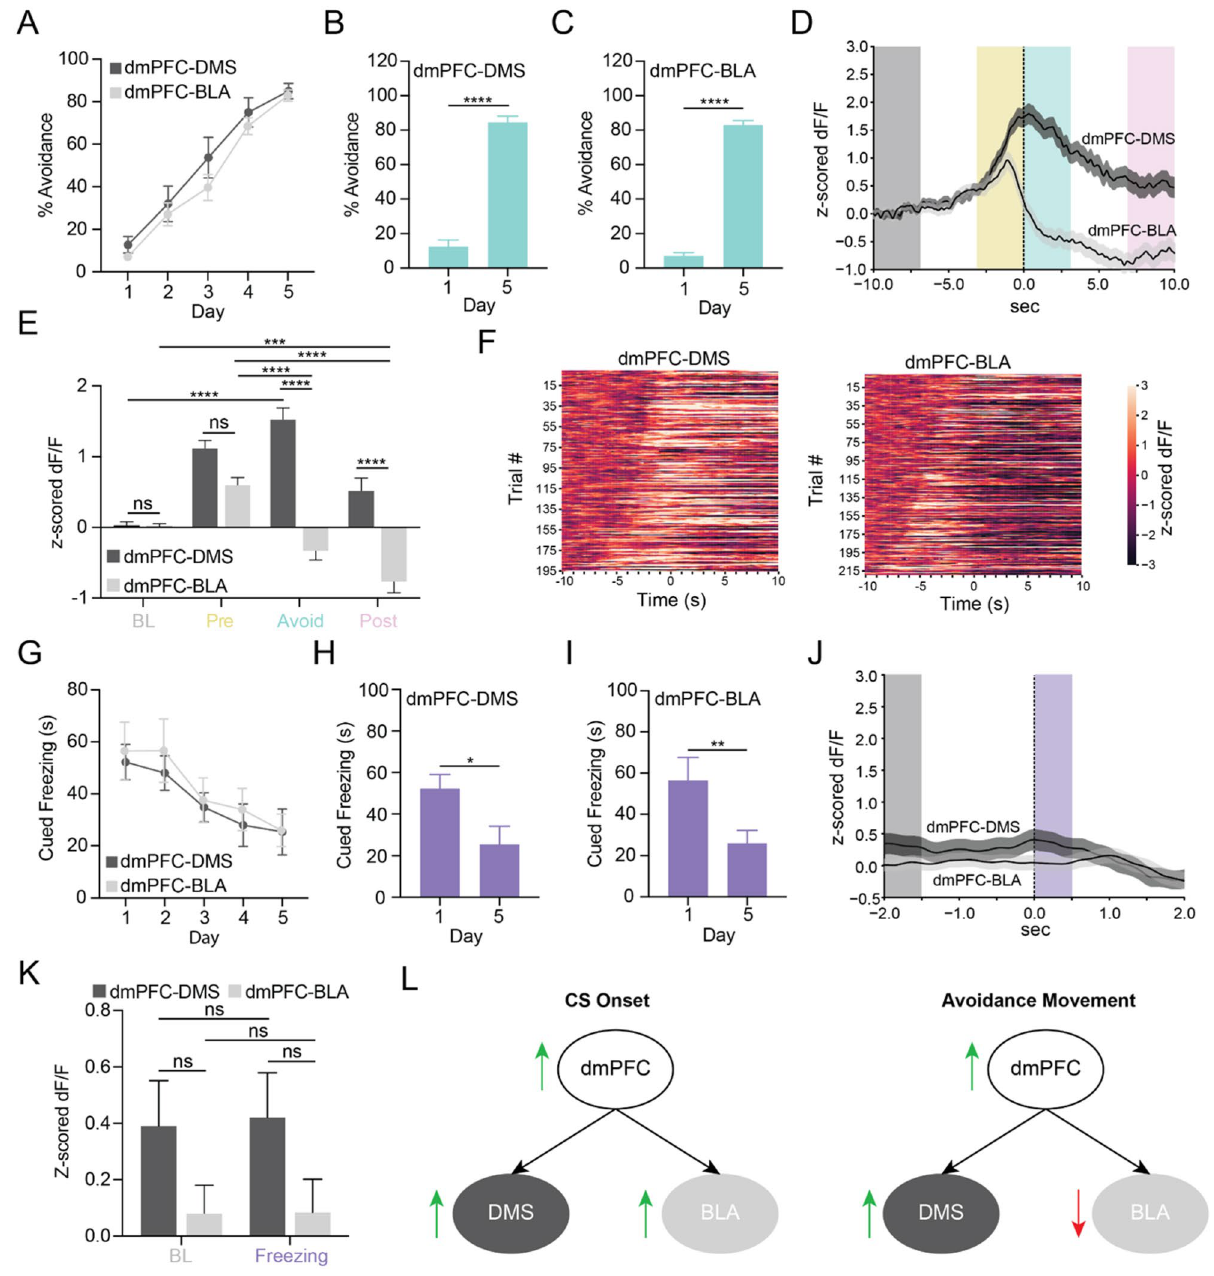
Figure 4. dmPFC-DMS and dmPFC-BLA projections show divergent encoding of active avoidance behavior. ( A ) Percent avoidance across training days in the dmPFC-DMS (dark grey line) and dmPFC-BLA (light grey line) cohort. ( B , C ) Percent avoidance significantly increases from Day 1 to Day 5 in the dmPFC-DMS (left) and dmPFC-BLA (right) cohort. ( D ) PETH shows increase in calcium signal in the dmPFC-DMS projection and decrease in calcium signal in the dmPFC-BLA projection during avoidance onset on Day 5. Dark grey line, mean ± SEM for dmPFC-DMS projection; light grey line, mean ± SEM for dmPFC-BLA projection; Grey box, baseline period (BL); yellow box, pre-avoidance period (Pre); teal box, avoidance period (Avoid); pink box, post-avoidance period (Post). ( E ) Quantification of avoidance PETH shows a significant increase in calcium signal in the avoid (0 to 3 s) period compared to baseline period (-10 to -7 s) for dmPFC-DMS projection. The dmPFC-BLA projection shows a significance decrease in signal during the avoid (0 to 3 s) period compared to the pre-avoid period (−3 to 0 s) and a significance decrease in signal during the post-avoid (7 to 10 s) period compared to the baseline (−10 to −7 s) and pre-avoid (−3 to 0 s) periods. ( F ) Heatmap of change in calcium signal for all individual avoidance trials for all mice from Day 5 aligned to avoidance onset and sorted from shortest to longest avoidance latency for the dmPFC-DMS (left) and dmPFC-BLA (right) projections. ( G ) Cued freezing in the dmPFC-DMS (dark grey line) and the dmPFC-BLA (light grey line) cohort. ( H , I ) Cued freezing significantly decreases from Day 1 to Day 5 in the dmPFC-DMS (left) and the dmPFC-BLA (right) cohorts. ( J ) PETH shows no change in calcium signal at freezing onset for either the dmPFC-DMS or the dmPFC-BLA projection on Day 1. Dark grey line, mean ± SEM for dmPFC-DMS projection; light grey line, mean ± SEM for dmPFC- BLA projection; Grey box, baseline period (BL); Purple box, freezing period (Freezing). ( K ) Quantification of freezing PETH shows no significant change in calcium signal during the freezing period (0–0.5 s) compared to the baseline period (−2 to −1.5 s). ( L ) Graphical abstract summarizing main findings from the study. ns = not significant, * p < 0.05, ** p < 0.01, *** p < 0.001, **** p <